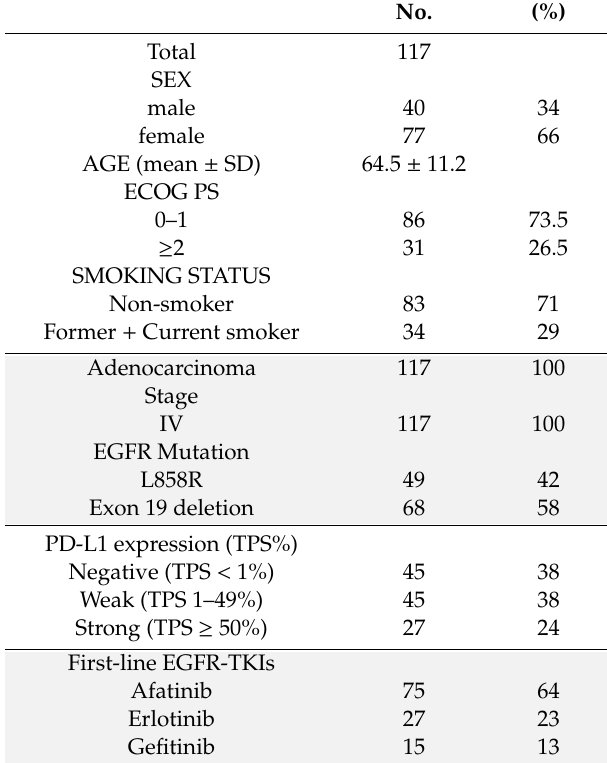
Table 1. Overall patient baseline characteristics.